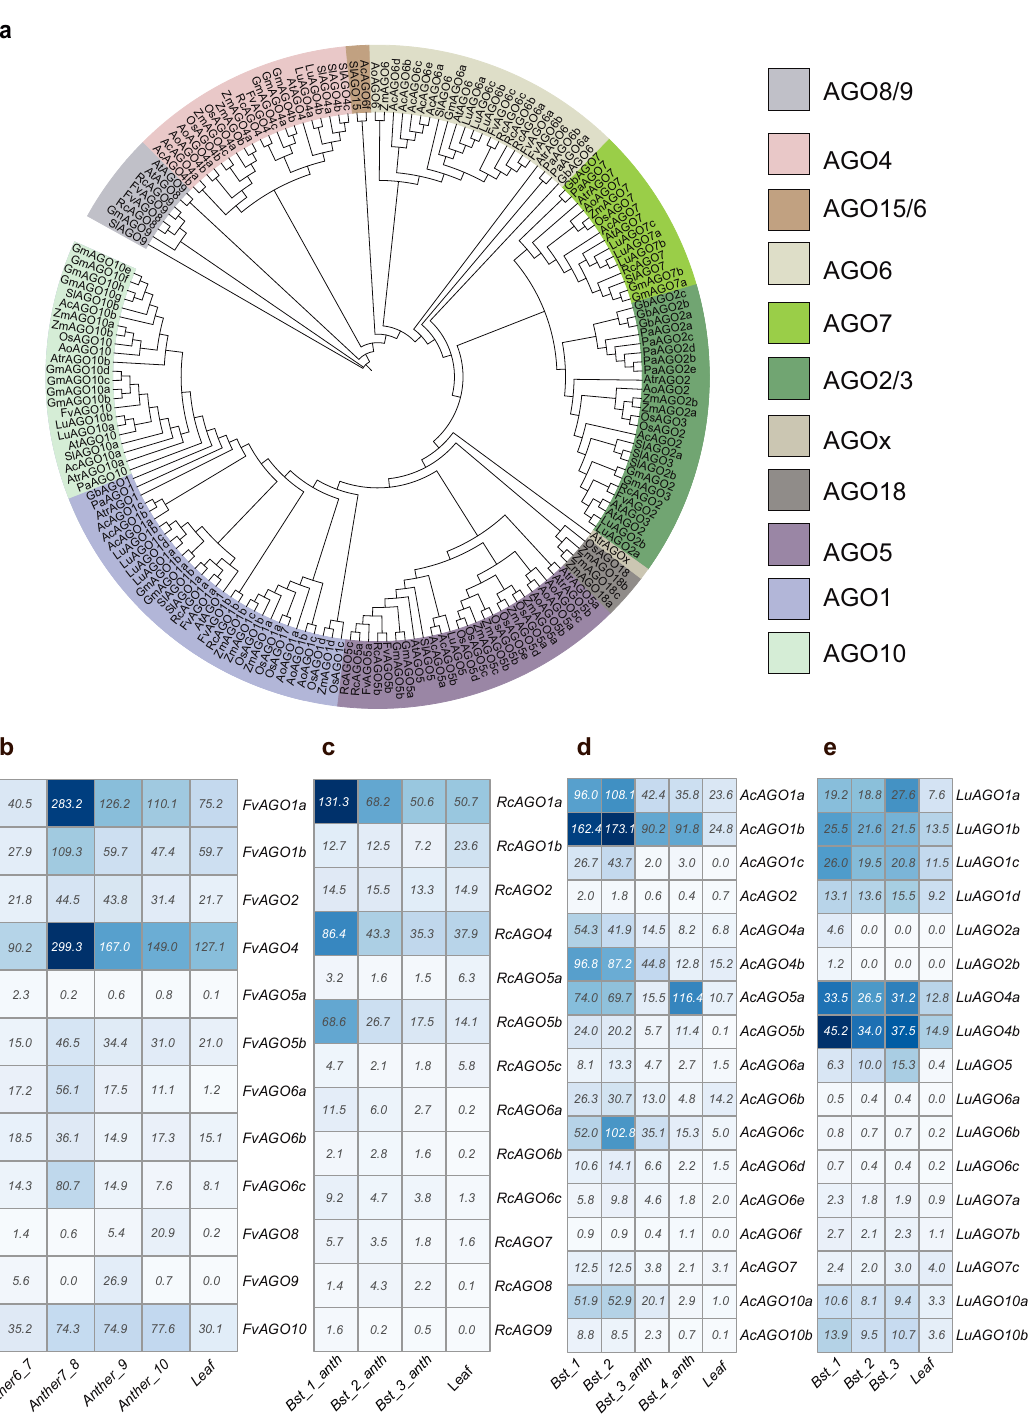
NATURE COMMUNICATIONS| (2021) 12:4941